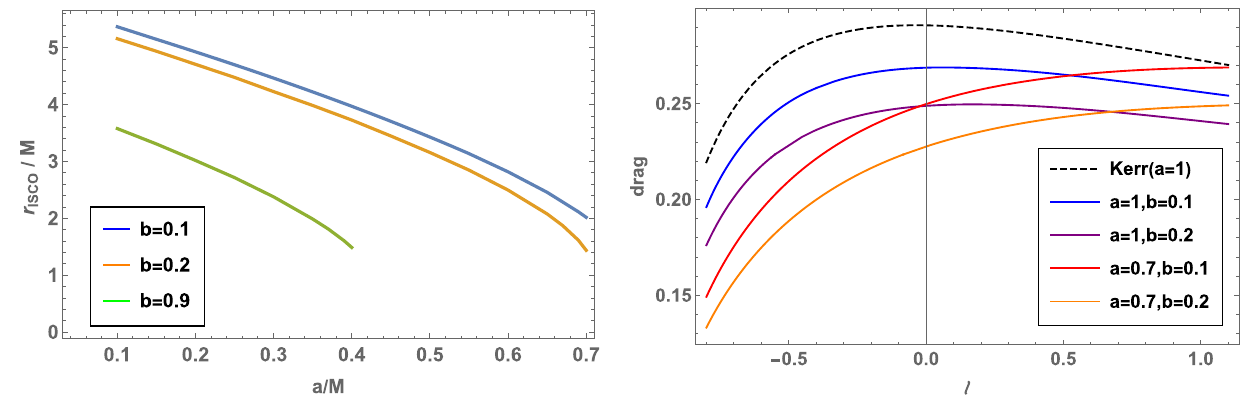
ter (cid:2) , for different models, with the simplification L = 0 and r = 1 . 5, which is approximately in the middle ergosphere. Notice the supremacy of the Kerr